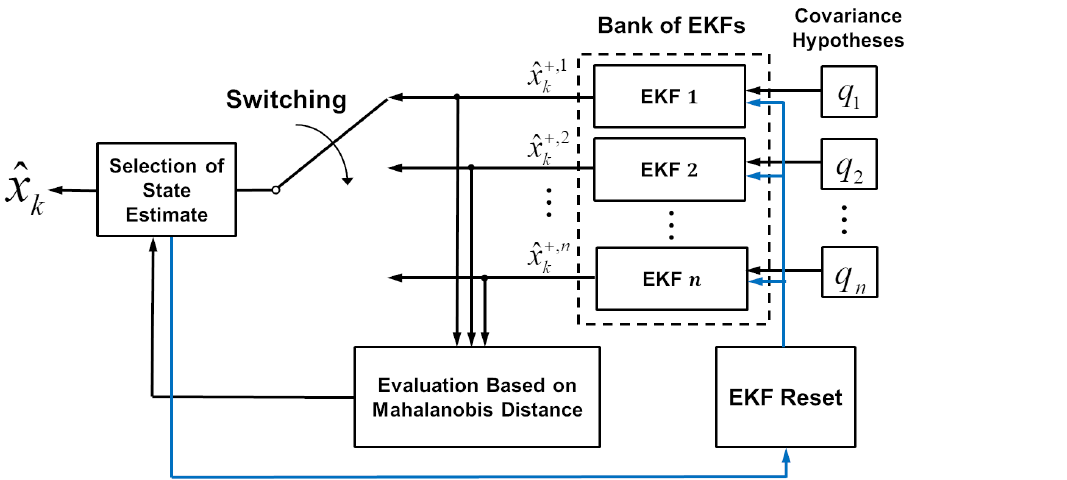
Figure 3. Structure of proposed switching extended Kalman filter bank